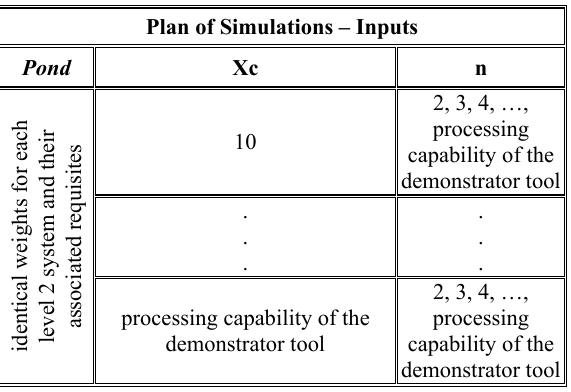
Table 2. Inputs of the plan of simulations.